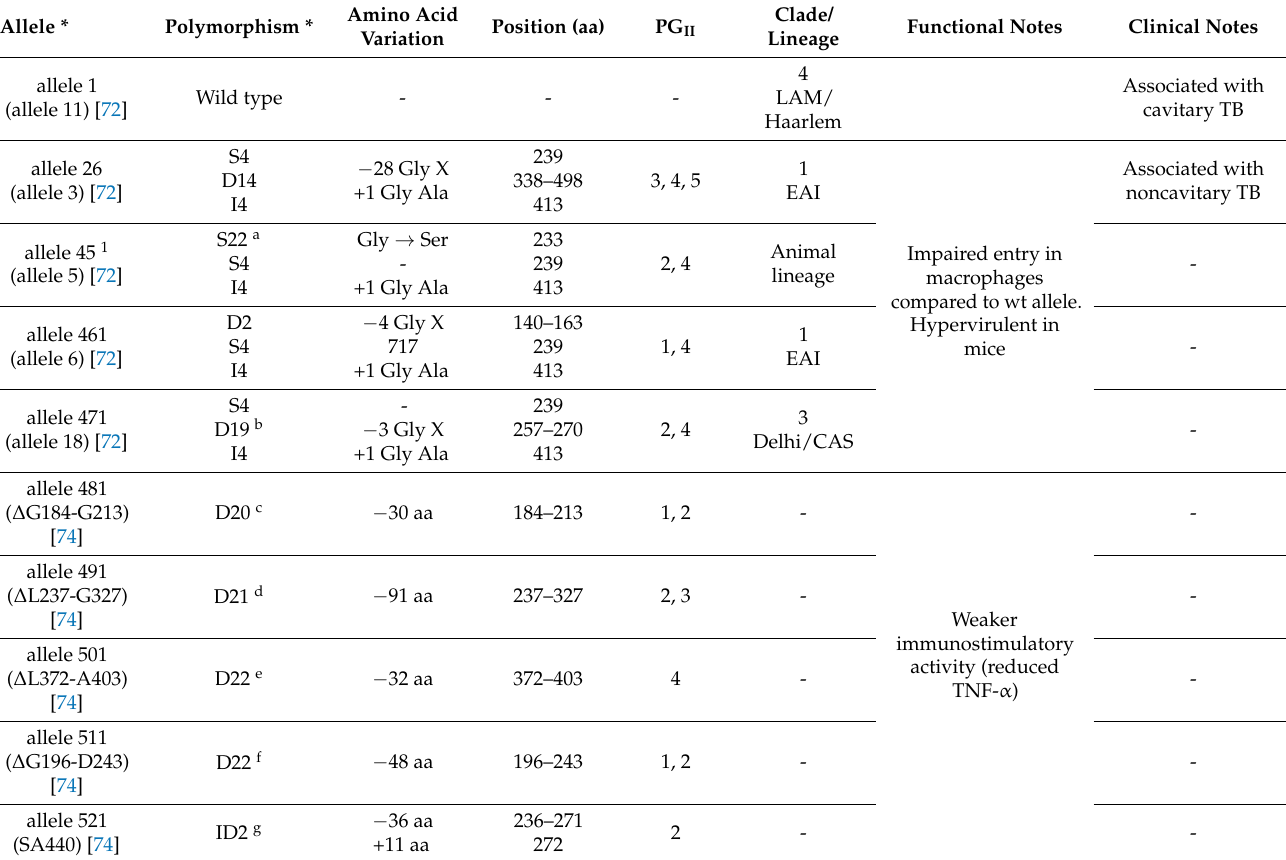
Table 3. Most frequent alleles identified in large collections of Mtb clinical strains. PG II modules of PE_PGRS33 are defined as indicated in Figure